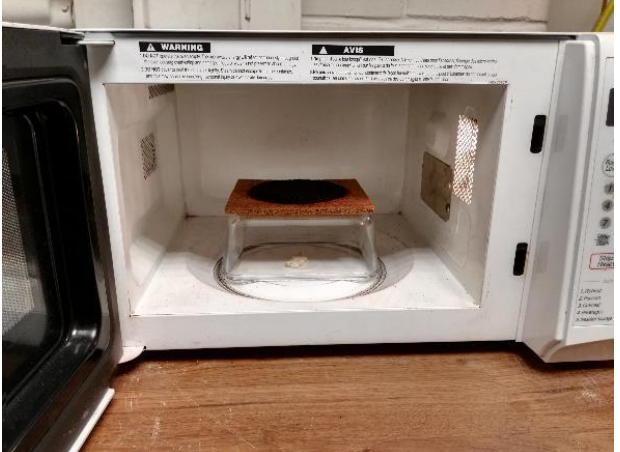
Figure 15. Test samples before microwave irradiation.